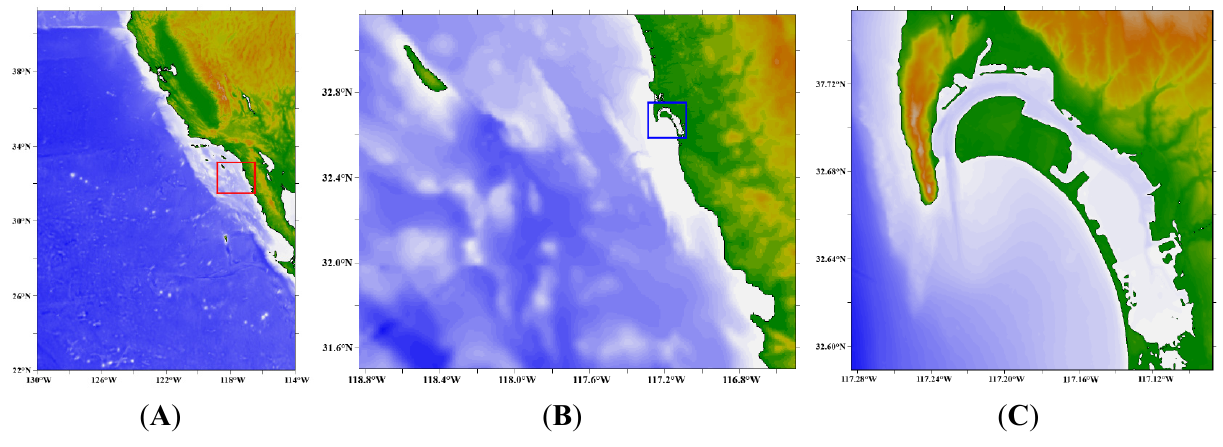
Figure 5. Extent of numerical grids A (left ), B ( middle ; shown as red rectangle within the A grid) and C ( right ; shown in blue colour within the B grid). C grid here only shows the current configuration but the extent of all four C grids (1892, 1938, 1945 and 2014) is the